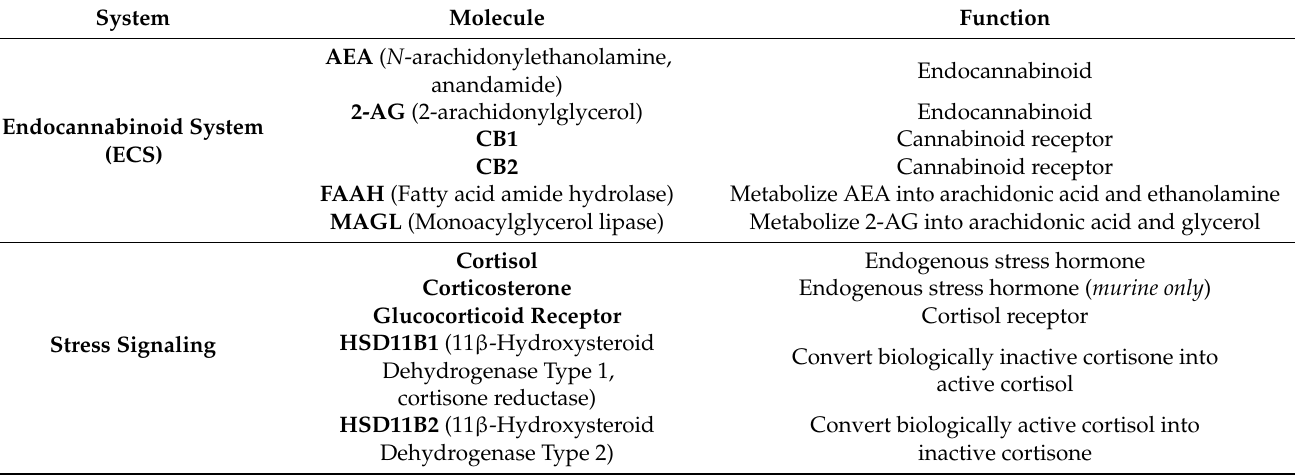
Table 1. Primary Components of the Mammalian ECS and stress signaling